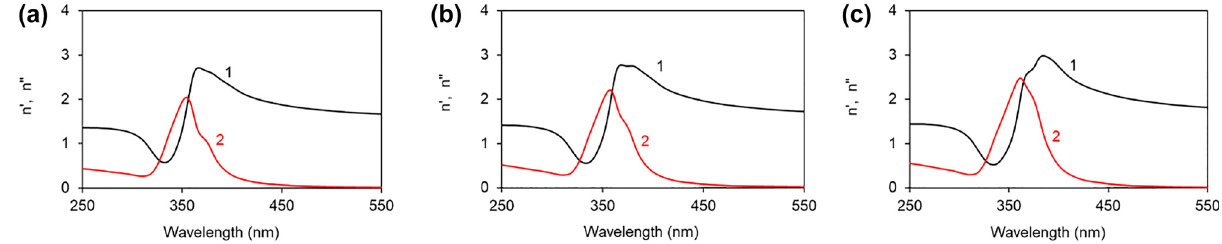
Figure 6: Calculated spectra of real (1) and imaginary (2) parts of refractive indexes of SPPs propagating at the interface between Ag and undoped PMMA (a), PVP (b), and PS (c) [21]. The real and imaginary dielectric permittivities of Ag are adopted from Ref. [20].